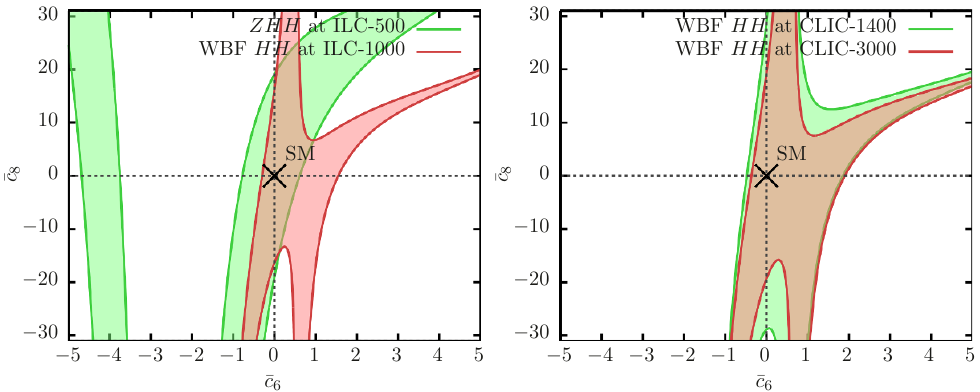
Figure 11 . 2 (cid:27) bounds in the ((cid:22) c 6 ; (cid:22) c 8 ) plane assuming SM cross sections for double Higgs production in the Scenario 2 described in the text. Left: ZHH at ILC-500 and WBF HH at ILC-1000. Right: WBF HH at CLIC-1400 and